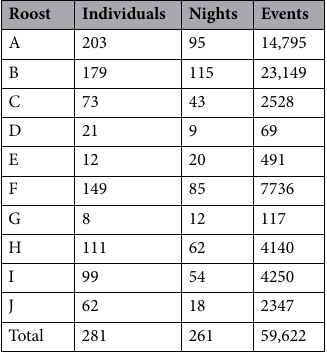
Table 1. Summary statistics of the number of unique PIT-tagged individuals, nights with records and behavioural events associated with emergence/entering and swarming recorded at ten tree roosts of Daubenton’s bats during three seasons.